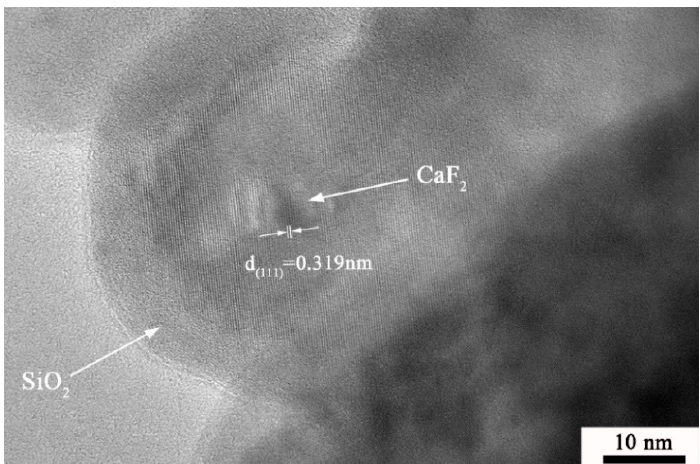
Figure 2. TEM micrographs of ( a ) CaF 2 and ( b ) CaF 2 @SiO 2 .